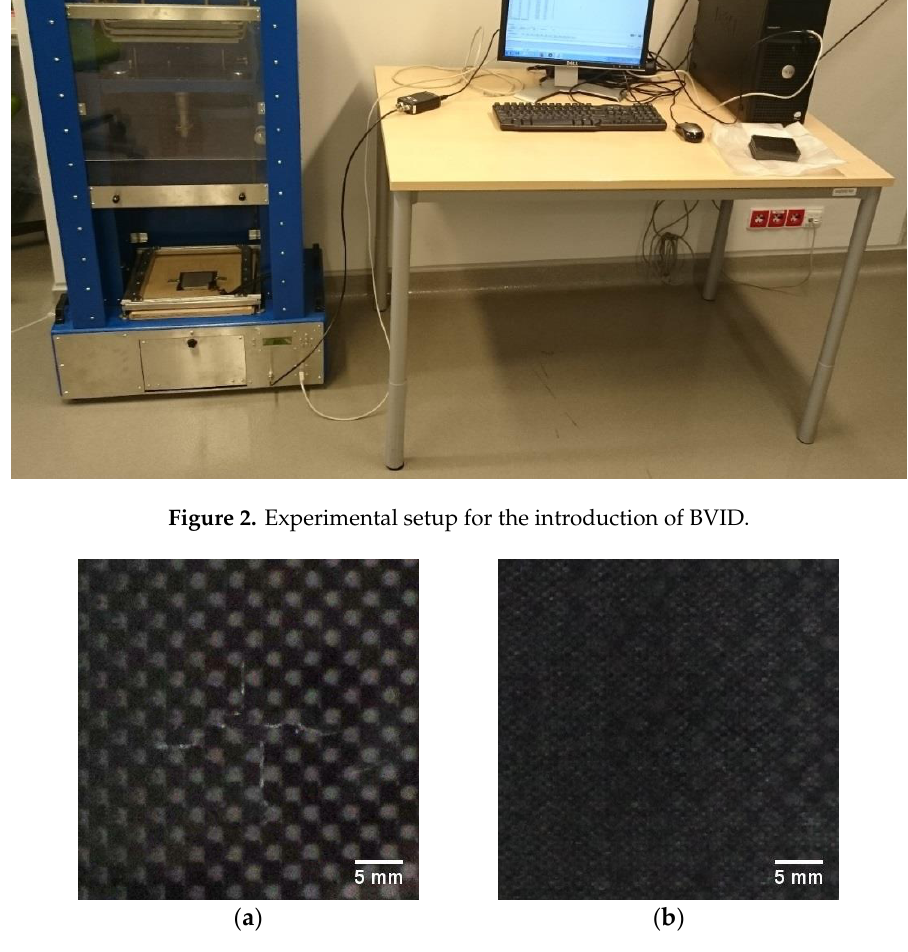
Figure 3. The carbon fiber-reinforced polymeric (CFRP) specimen with impact damage: ( a ) a top view; ( b ) a rear view.